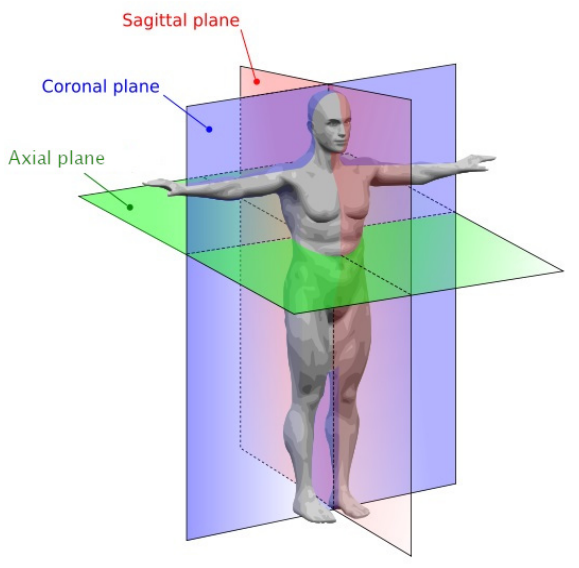
Figure 1. Planes of MRI imaging. axial (green), coronal (blue) and sagittal